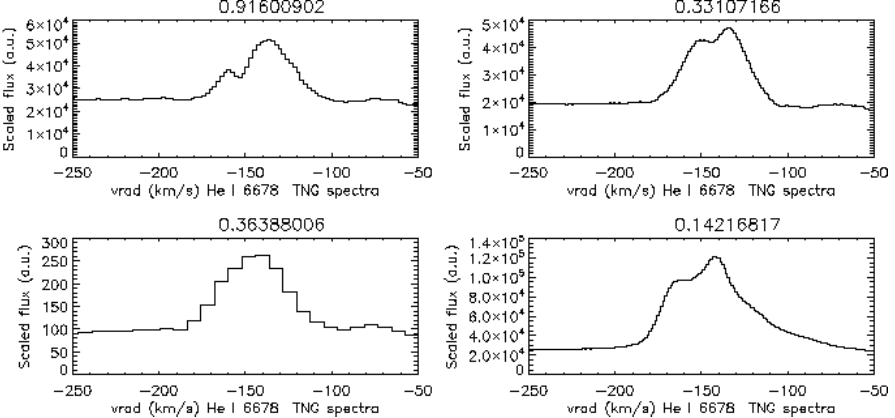
Fig. 6b. Examples of the structure of the He I 6678 ˚A singlet line profiles; as in Figure 6a, from the TNG and Asiago